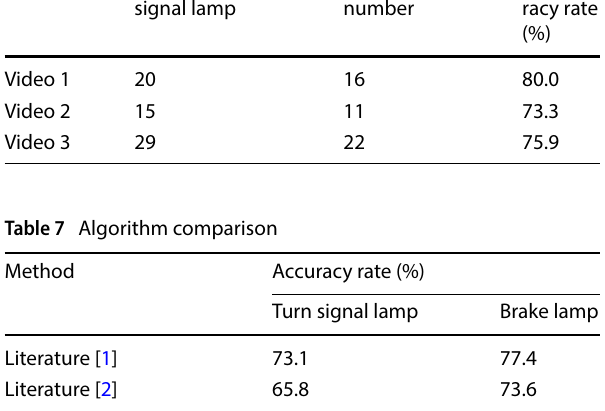
Table 6 Right turn signal lamp (right signal lamp on and left signal lamp off) detection Number of right turn signal lamp